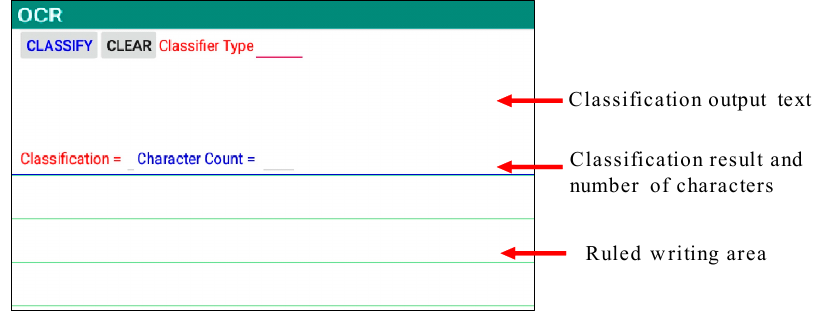
Figure 15. A simple user interface for the system.